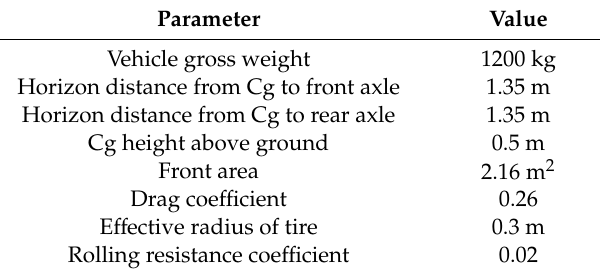
Figure 10. Vehicle body system model and parameters. Table 5. Vehicle body parameters.